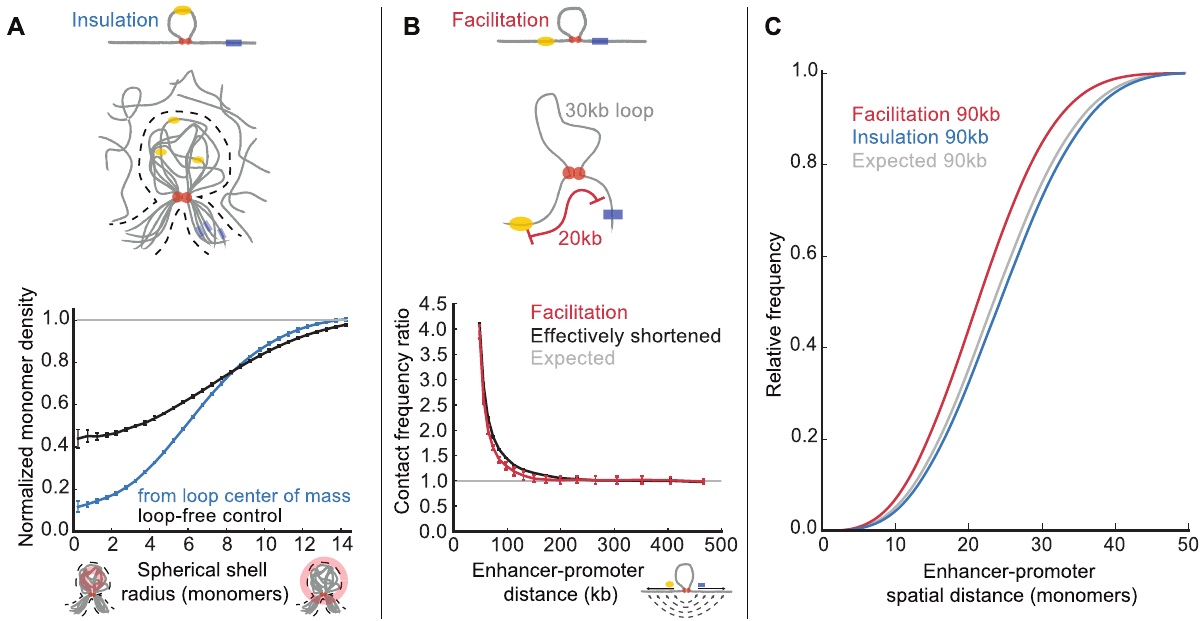
Figure 4. Mechanisms of insulation and facilitation. ( A ) ( top ) Illustration of the insulation mechanism: strong dynamic steric exclusion by a chromatin loop is shown by a superposition of loops in multiple conformations (grey, with enhancer and promoter) and their sterically excluded region (dashed lines), surrounded by other distal regions of chromatin (grey). ( bottom ) Density of distal monomers (i.e. outside the loop and . 10 kb from the loop base) as a function of radial distance from the center of mass of the loop. The loop-free control exactly repeats this procedure for an equivalent region without a loop. Both are normalized using respective radial-position dependent spatial density (Methods). ( B ) ( top ) Illustration of facilitation mechanism: an E-P pair flanking a loop has an effectively shorter genomic distance; here an E-P pair with 50 kb separation and a 30 kb loop behaves similarly to an E-P pair separated by 20 kb in a region without a loop. ( bottom ) Comparison of contact frequency ratios for the above situations, as a function of E-P distance. ( C ) Simulated cumulative distribution of spatial distances ( in silico FISH) for an E-P pair with a genomic distance of 90 kb.